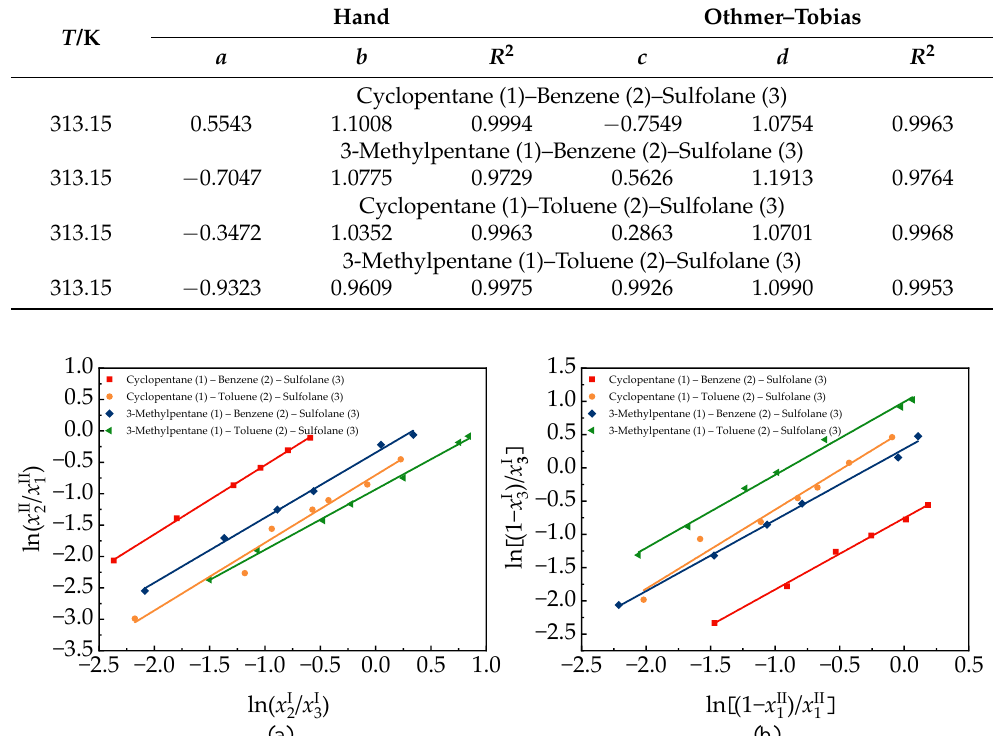
Table 3. The parameters of Hand and Othmer–Tobias equations for ternary LLE data under experi- mental conditions.